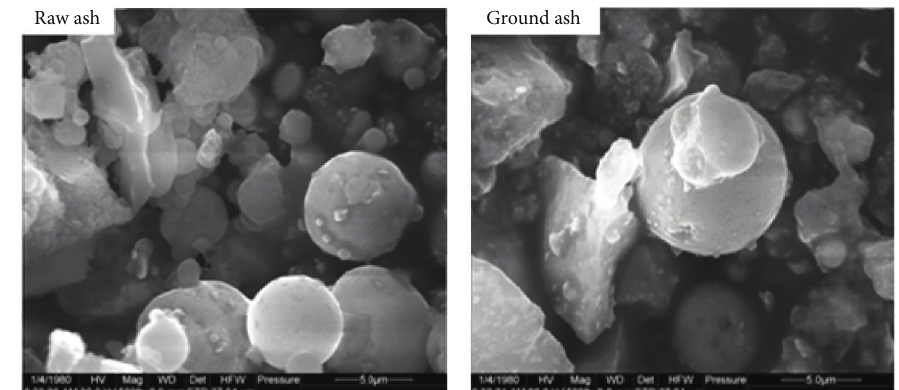
Figure 1: Particle morphology of raw ash and ground ash.